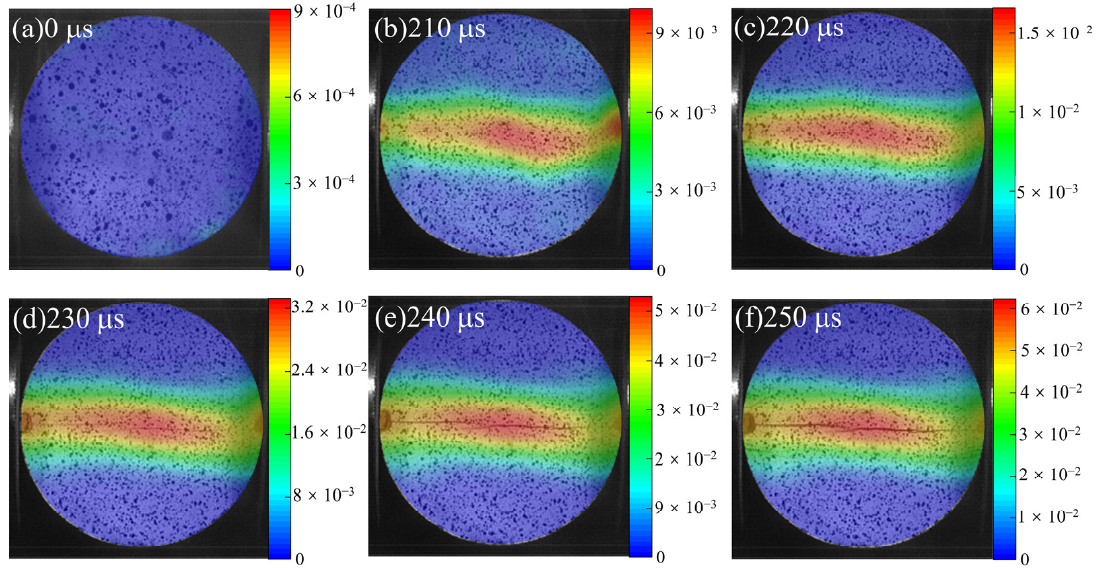
Figure 7. Full-field strain of the Andesite specimen at 4.88 m/s striking velocity: ( a ) 0 µ s; ( b ) 210 µ s; ( c ) 220 µ s; ( d ) 230 µ s; ( e ) 240 µ s; ( f ) 250 µ s.